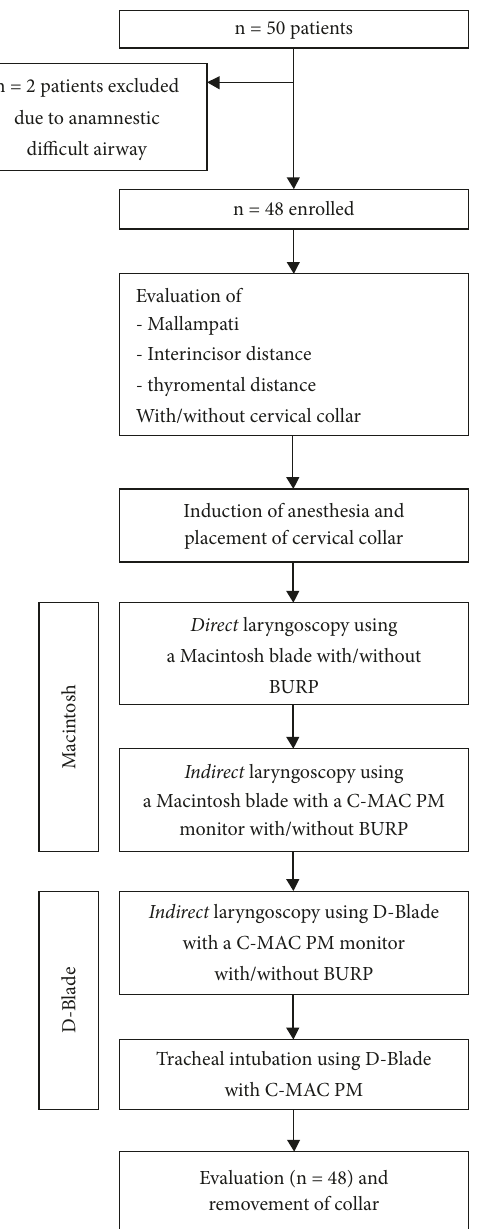
Figure 2: Study Flowchart . Flowchart study design. Supplementary online